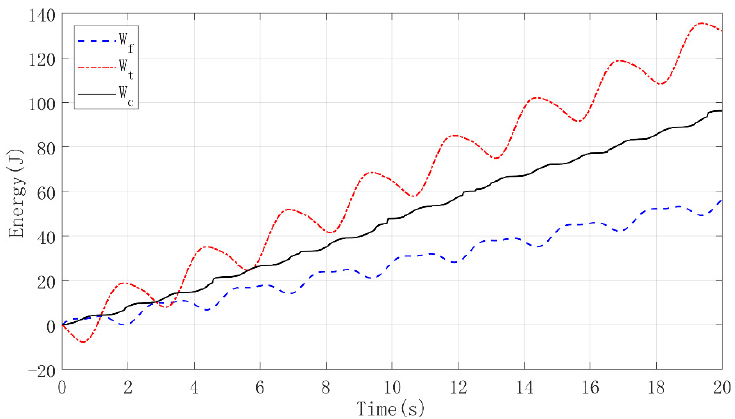
Figure 18. The time series of the forces and motor excitation motion.